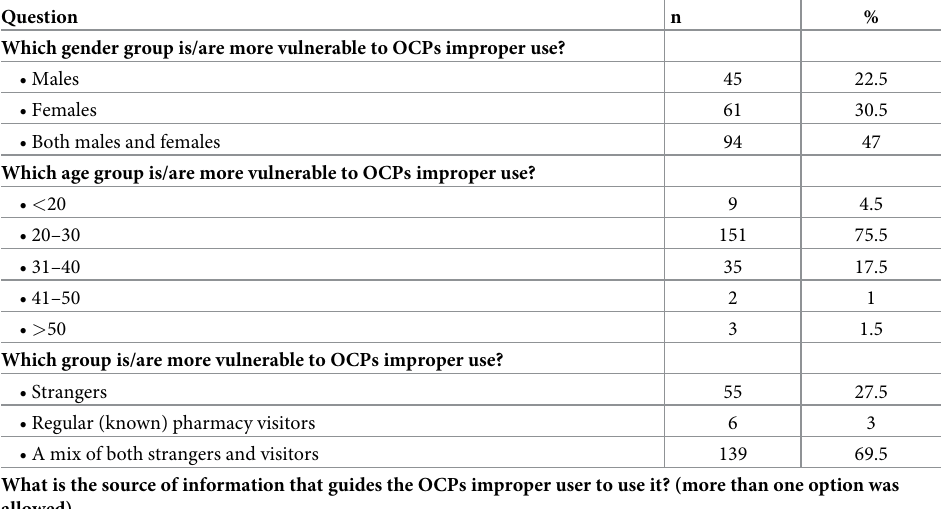
Table 2. Reported information about the OCPs improper users and the most commonly used products, according to the pharmacist’s observations for the OCPs improper use cases (n =